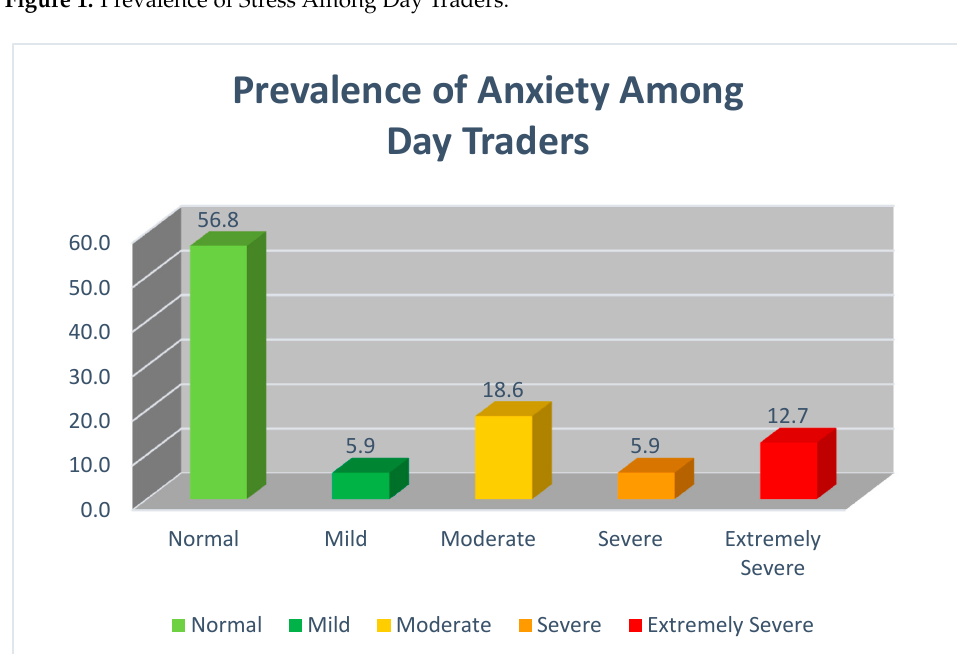
Figure 2. Prevalence of Anxiety Among Day Traders. The normality of anxiety and stress scores were between ±3, and the variables were normally distributed (Table 6). SD = 7.98), with a mean difference of 7.04 as revealed by post hoc pairwise comparisons using Tukey